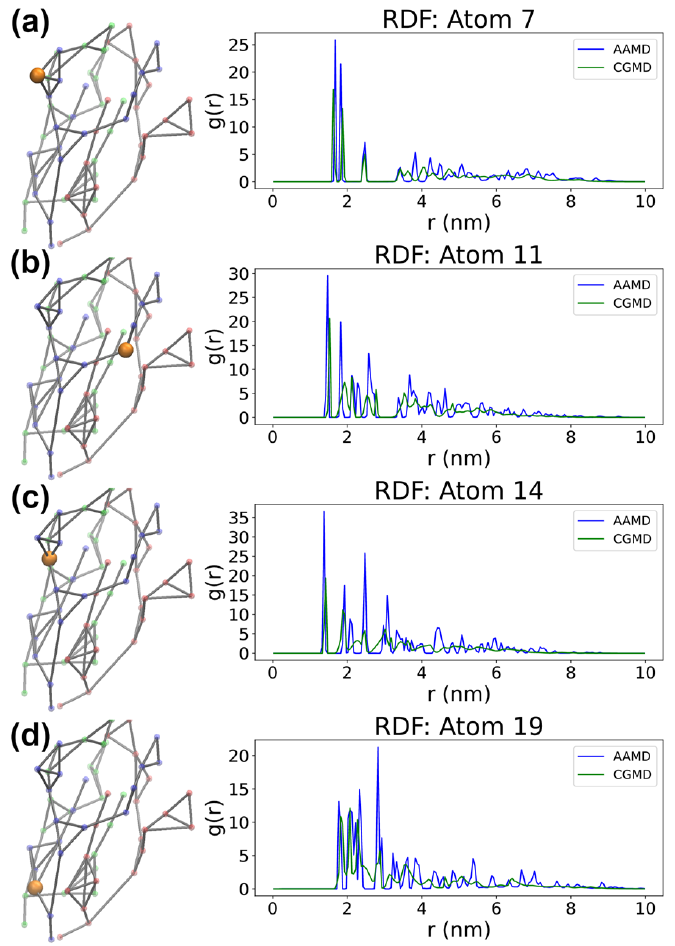
Figure 5. RDF plot from single reference atom comparison of the CGMD simulations vs. the AAMD validation simulations. In the colored beads visualizations: blue—chain A; red—chain B; green— chain C; orange—selected atoms. Spearman’s correlation coefficients: ( a ) 0.7472; ( b ) 0.6560; ( c ) 0.6278; ( d ) 0.5690.